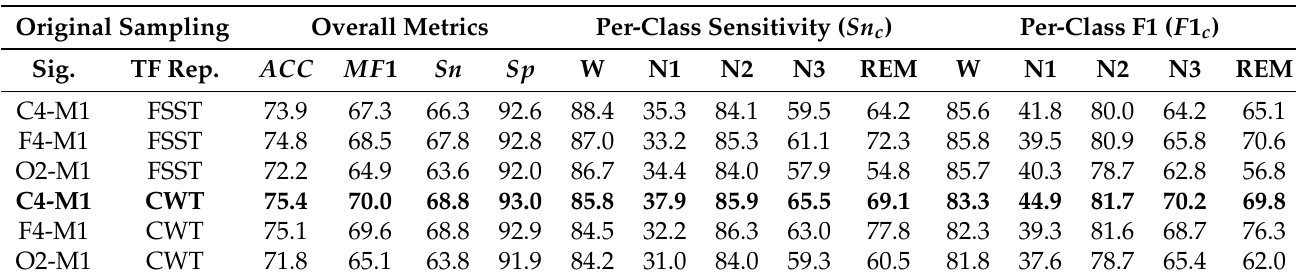
Table 2. Overall test performance results for the CNN transfer learning networks over different EEG channels and different time–frequency imaging approaches.